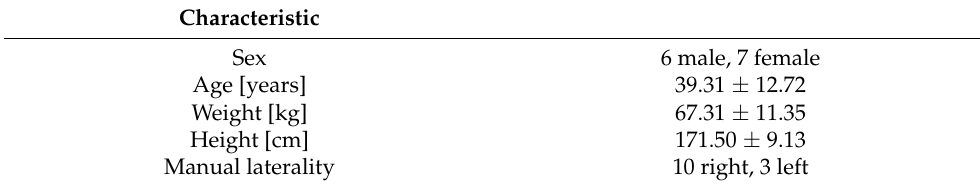
Table 1. Anthropometric characteristics of the study population.